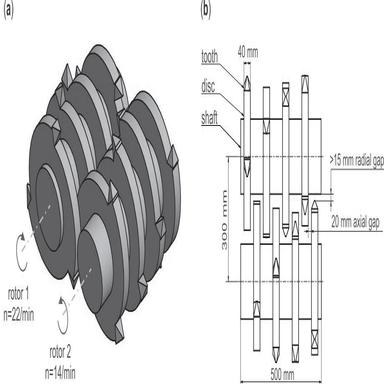
The shredder used in this experimental study is a pilot rotary shear with two shafts that counter-rotate at low speed: (a) isometric view, and (b) top-view of the rotary shear.